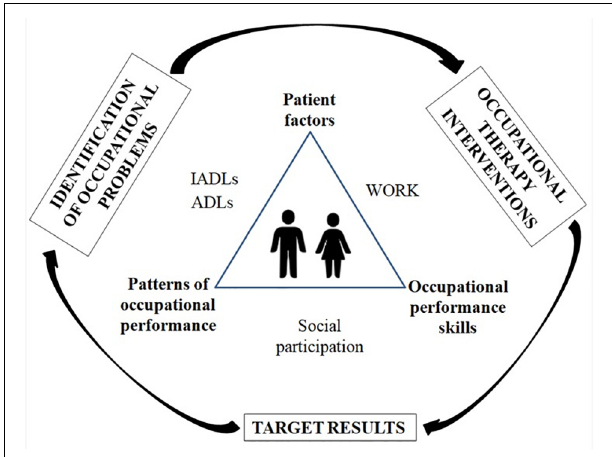
FIGURE 2 | Flowchart of the proposal for an occupational therapy intervention plan for people living with HTLV-1. ADLs, activities of daily living; IADLs, instrumental activities of daily